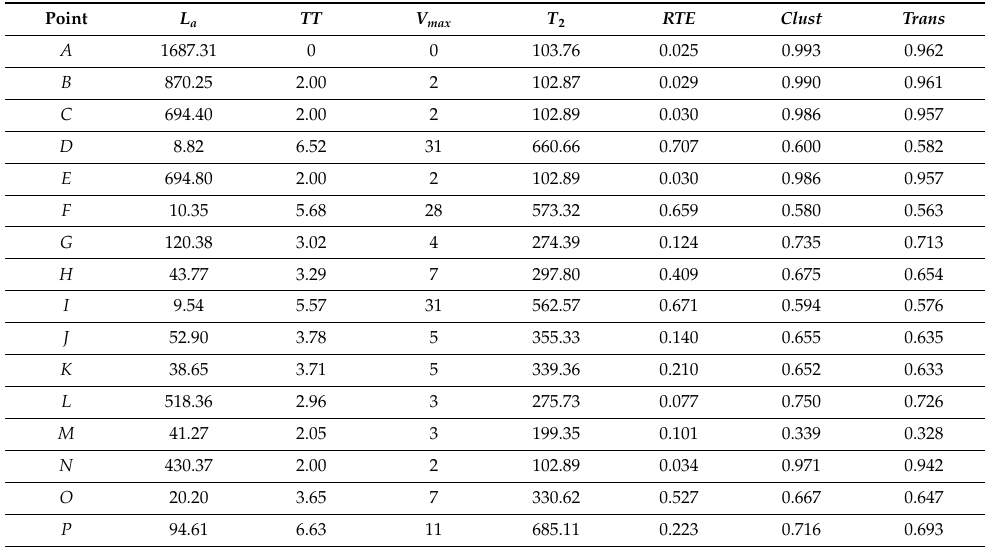
Table 3. The recurrence statistics. The same RQA parameters as in Table 2 but for ε =